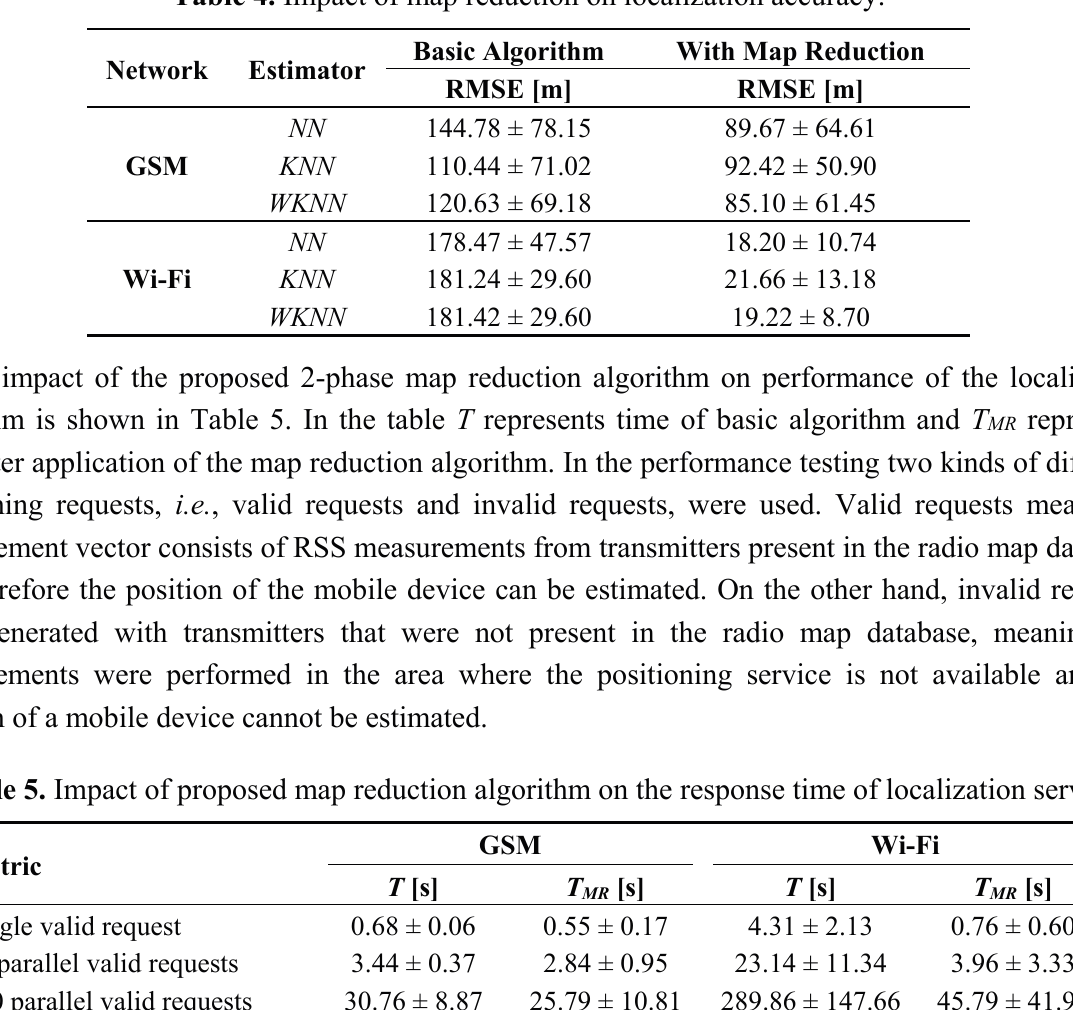
Table 4. Impact of map reduction on localization accuracy.